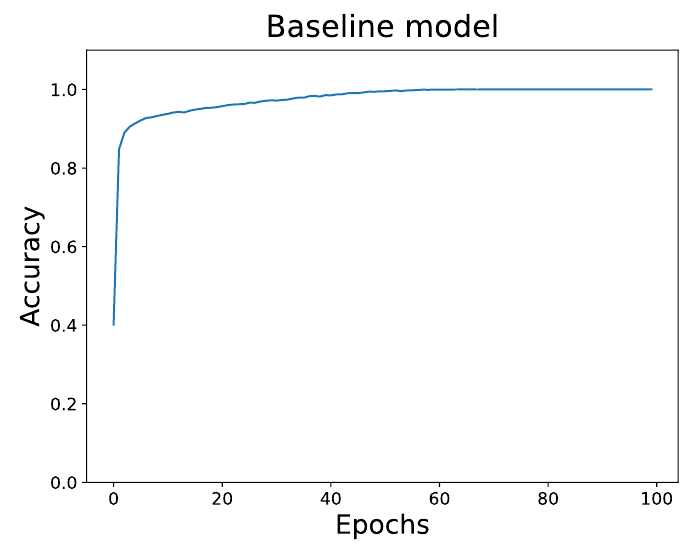
Figure 20. Baseline model training